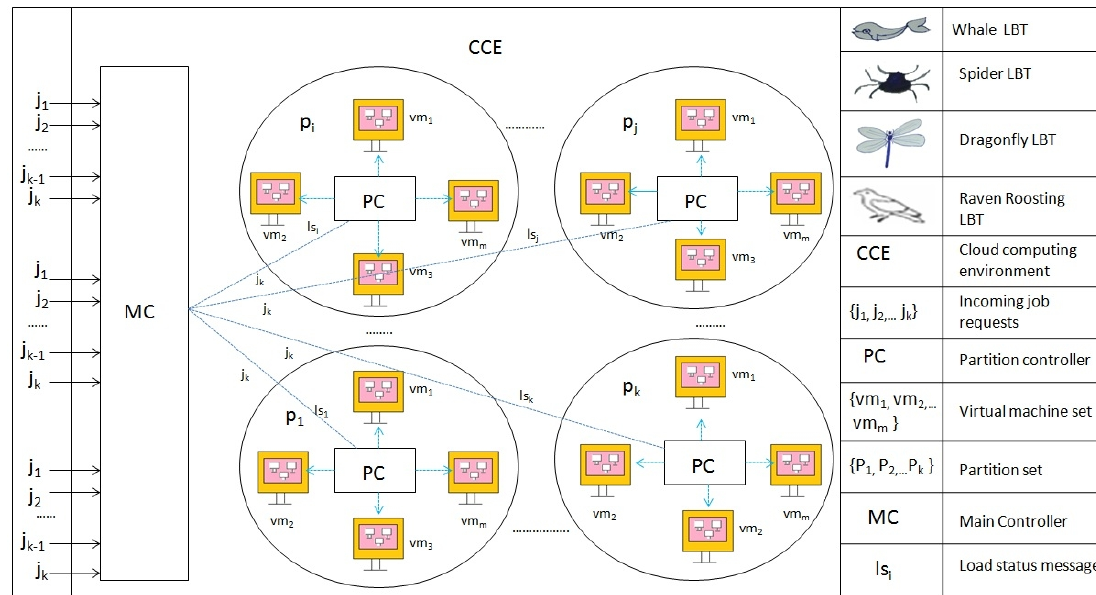
Figure 1: High level view of the system